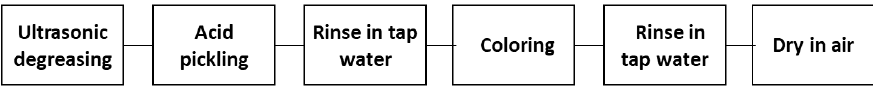
Figure 2. Flow chart of the whole process.